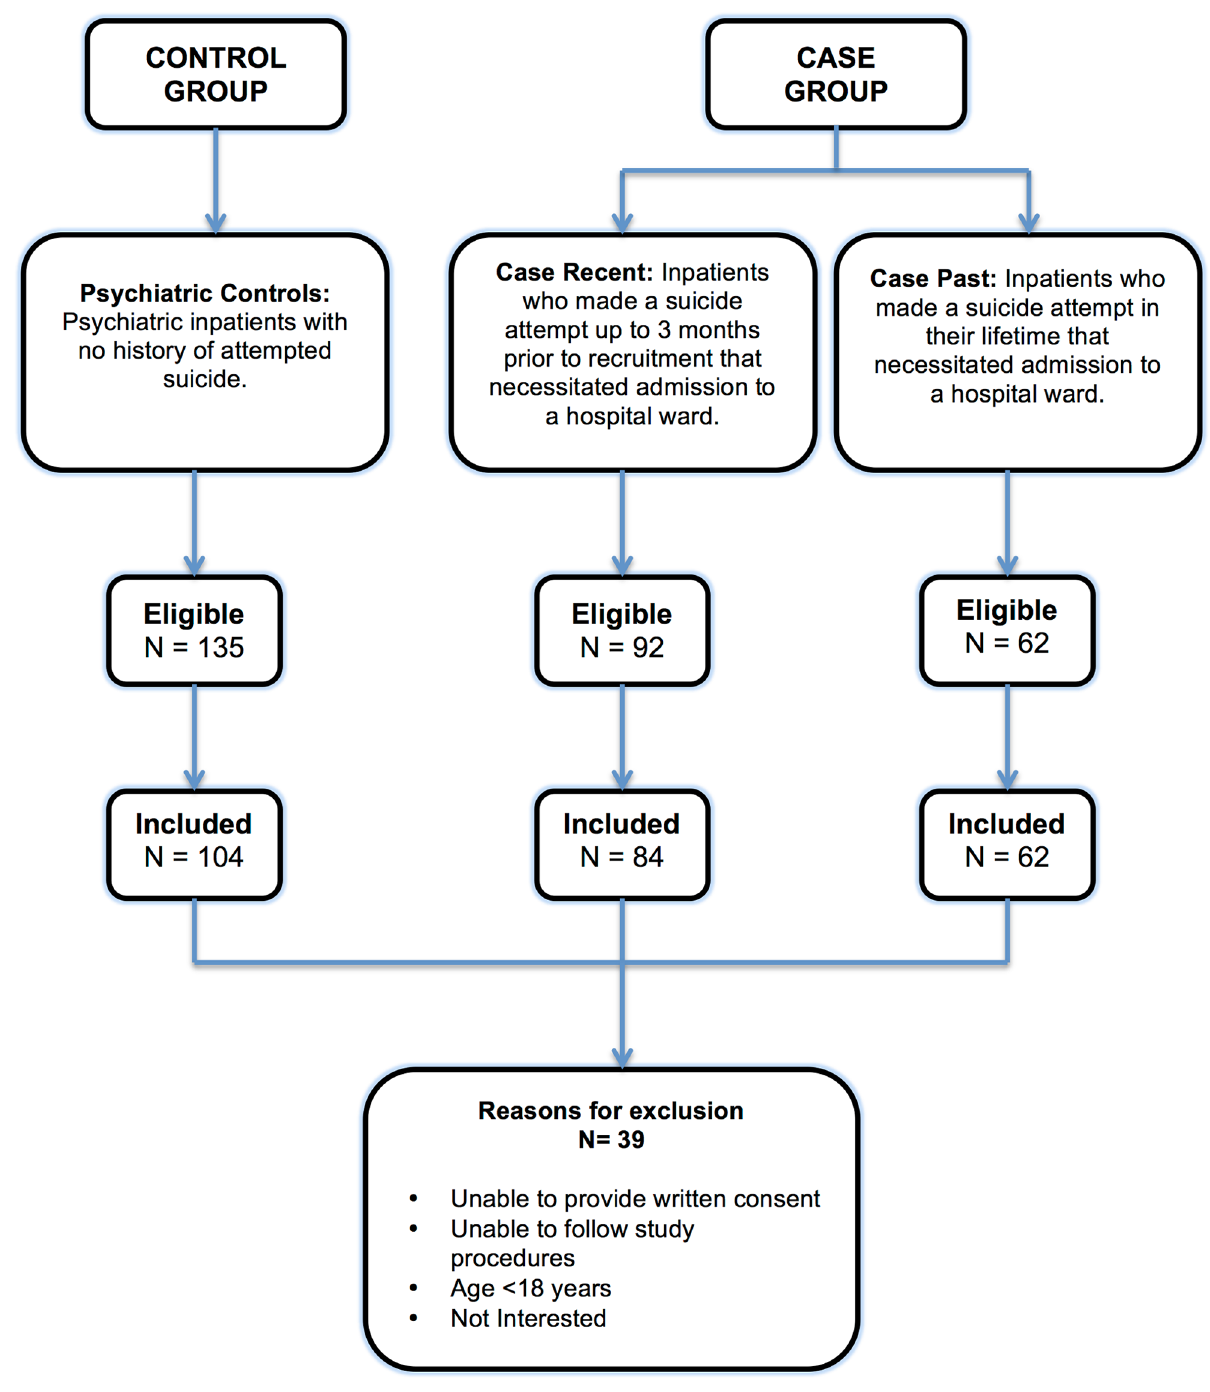
Fig 1. Eligibility and recruitment